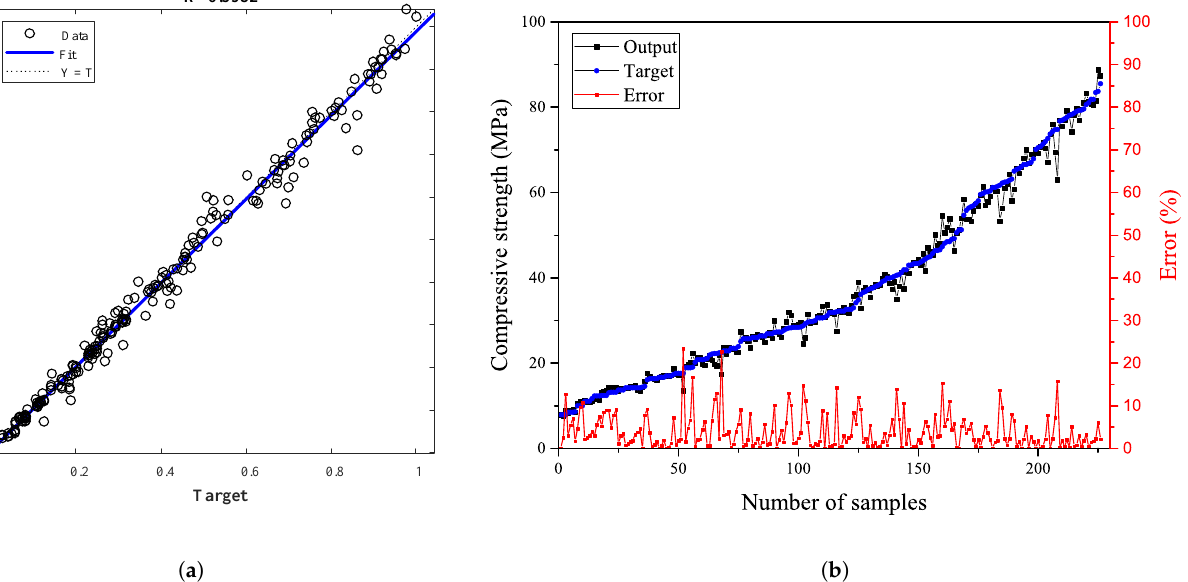
Figure 5. ( a ) The regression of the MLP network, ( b ) The comparison of the predicted outcomes using MLP network and experimental data along with the error.